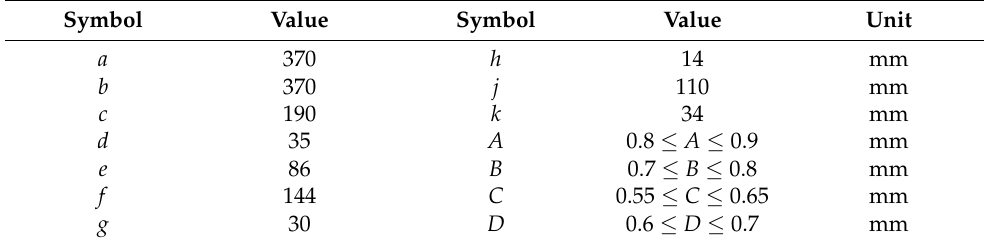
Table 1. Dimensions of the XYZ